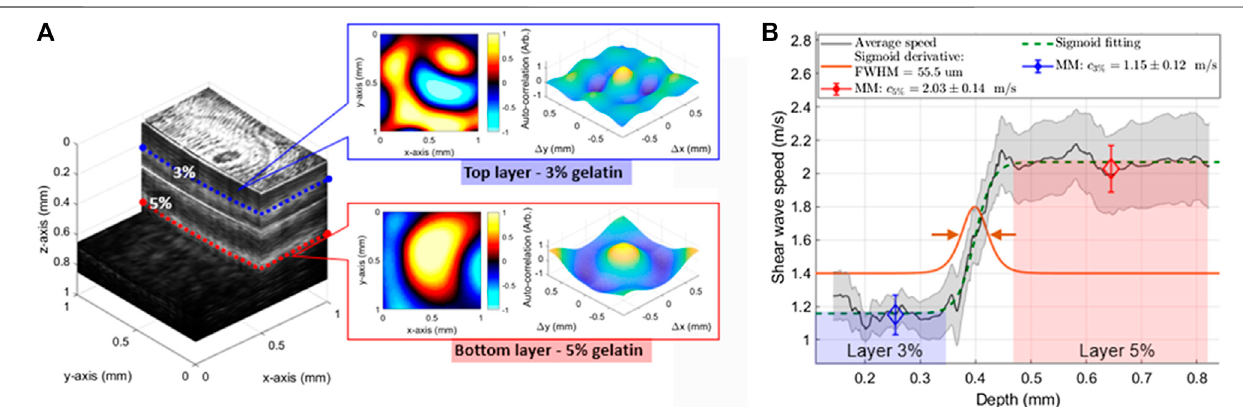
FIGURE 6 | (A) Horizontally distributed layered phantom (1 × 1 × 1 mm 3 ) showing a stiffer bottom layer (gelatin concentration of 5%) and softer top layer (gelatin concentration of 3%) obtained using OCT. Motion frames (particle velocity) and 2D autocorrelation plots are calculated within each layer with notable wavelength and main-lobe spreading differentiation, respectively. (B) Average speed transition along depth from the 3 – 5% concentration layers of the phantom. Mean ± standard deviation (N (cid:2) 5 measurements). For elastography resolution characterization, a sigmoid function was fi tted to the speed pro fi le). The average full-width half- maximumlayertransitionwasfoundtobe55 . 5 μ m ± 17 . 3 μ m. Thedepth-dependentspeedpro fi le wascompared againstmechanicaltesting results( N (cid:2) 3samplesper gelatin concentration) showing consistency of results in each layer. Reprinted by permission from Springer Nature from Ref.